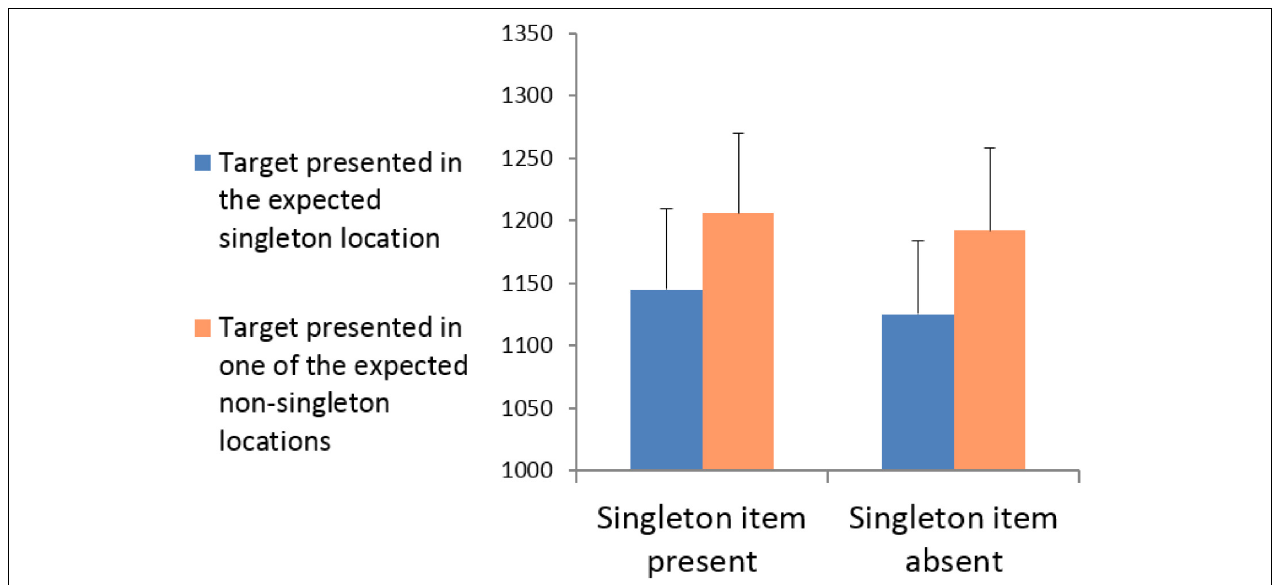
FIGURE 2 | Experiment 1: Mean RTs for targets presented in the singleton location vs. targets presented in the non-singleton locations for singleton-present and singleton-absent